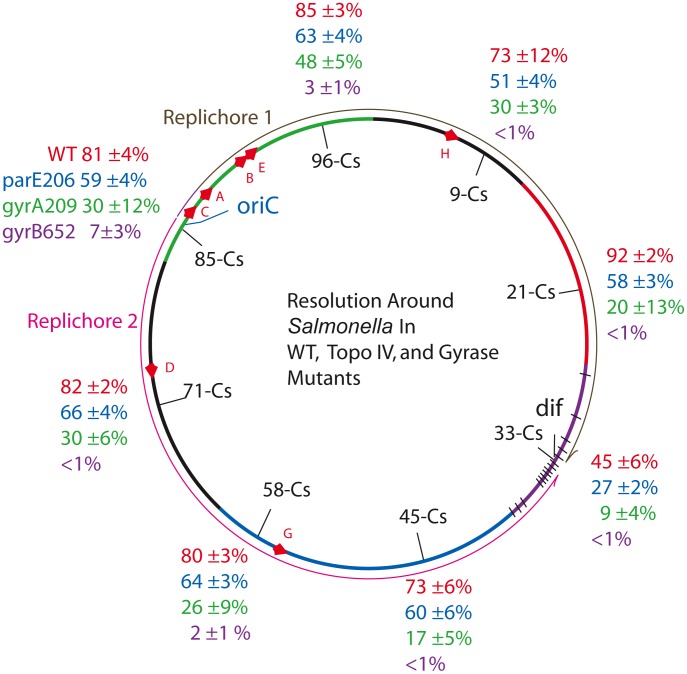
Resolution efficiencies in the Salmonella chromosome decline in strains carrying TS mutations in gyrase and Topo IV, even when cells are grown at permissive temperature (30°).Recombination reactions at 8 locations around the Salmonella chromosome was studied in 32 strains described in Table 1. The experiment covers the 6 macrodomains of E. coli, shown as color coded arcs superimposed on the Salmonella map: green, Ori domain; black, Right Unstructured domain; red, Right domain; purple, Ter domain with black hatches showing matS sites; blue, Left domain; and black, Left Unstructured domain [41]. The direction of replication fork movement in replichore 1 (brown) or 2 (pink) is shown by arrows outside the circle. Each strain had a 9 kb Lac-Gn supercoil sensor inserted between consecutive genes, plus a plasmid that contains a thermo-inducible γδ resolvase with a 30 min half life (Materials and Methods). Recombination data and estimated values of apparent diffusible supercoiling for each experiment are reported in Table 1.